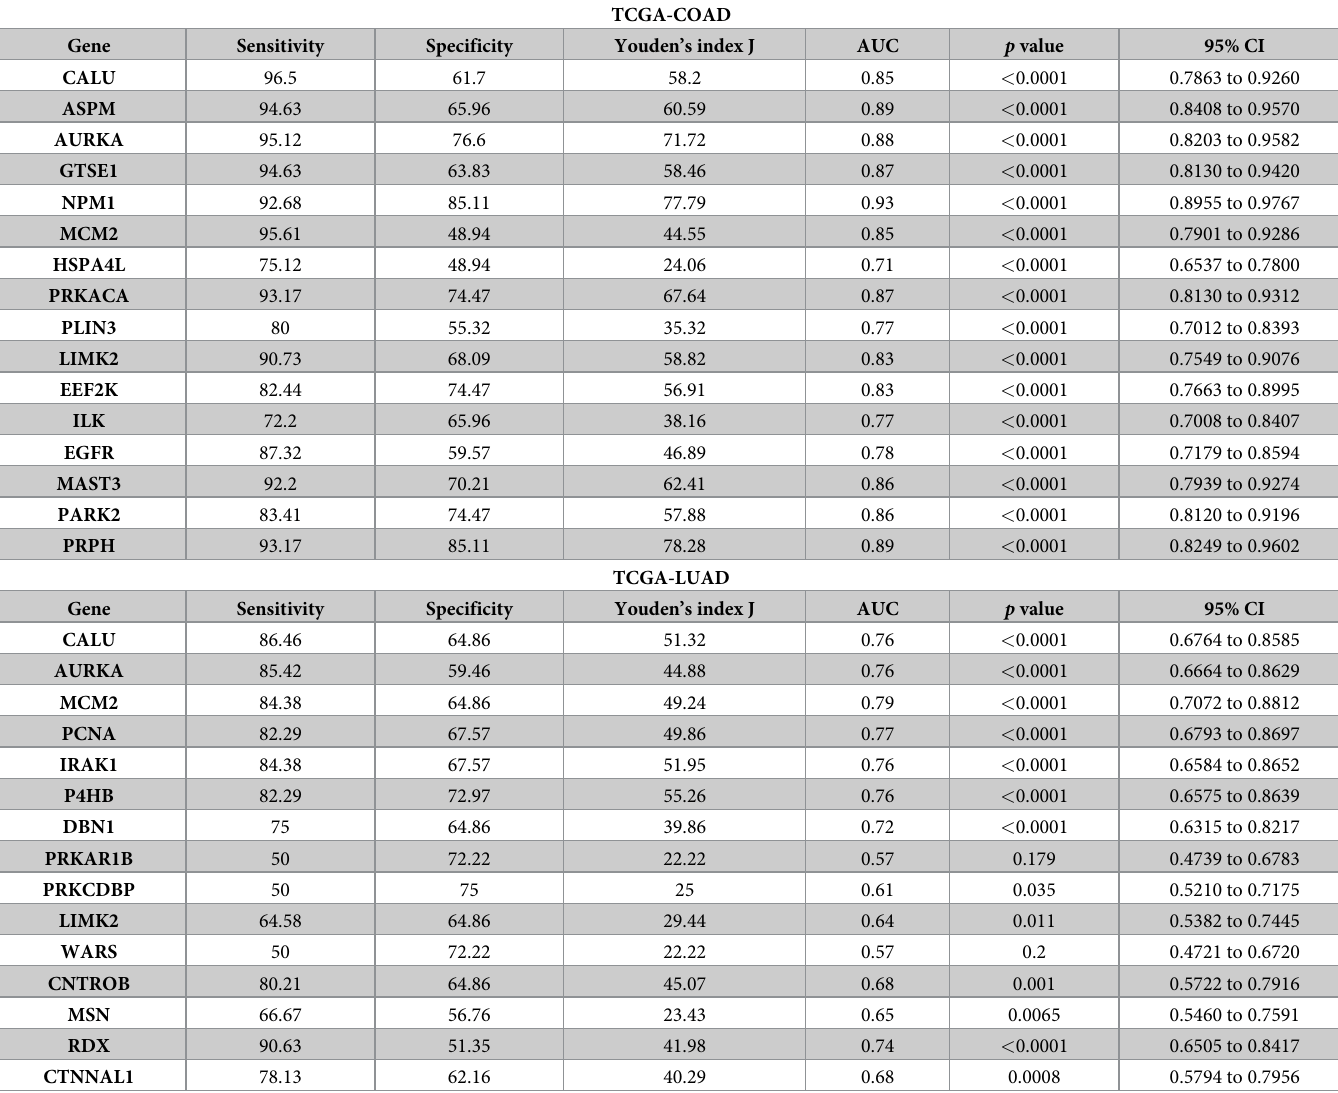
Table 4. Diagnostic performance of DEGs in TCGA-COAD and LUAD